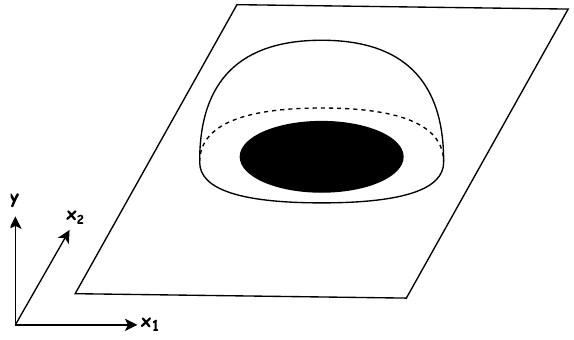
Figure 2 . A hemisphere over a black disc in the ( x 1 ; x 2 ) plane. An ~ S 3 (cid:12)bration over this surface is topologically an S 5